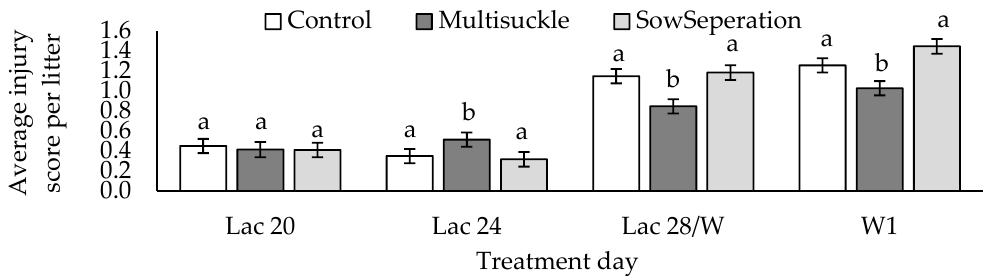
Figure 5. The e ff ect of lactation housing methods on the injury score of piglets (Di ff erent superscripts Figure 5. The effect of lactation housing methods on the injury score of piglets (Different superscripts note significant di ff erences within treatment day, a,b p < 0.001, adjusted non-transformed mean and note significant differences within treatment day, a,b p < 0.001, adjusted non-transformed mean and SEM are presented (data was Sqrt transformed for SEM are presented (data was Sqrt transformed for analysis). Table 7. The change in piglet condition and stress and the effect of treatment by day.